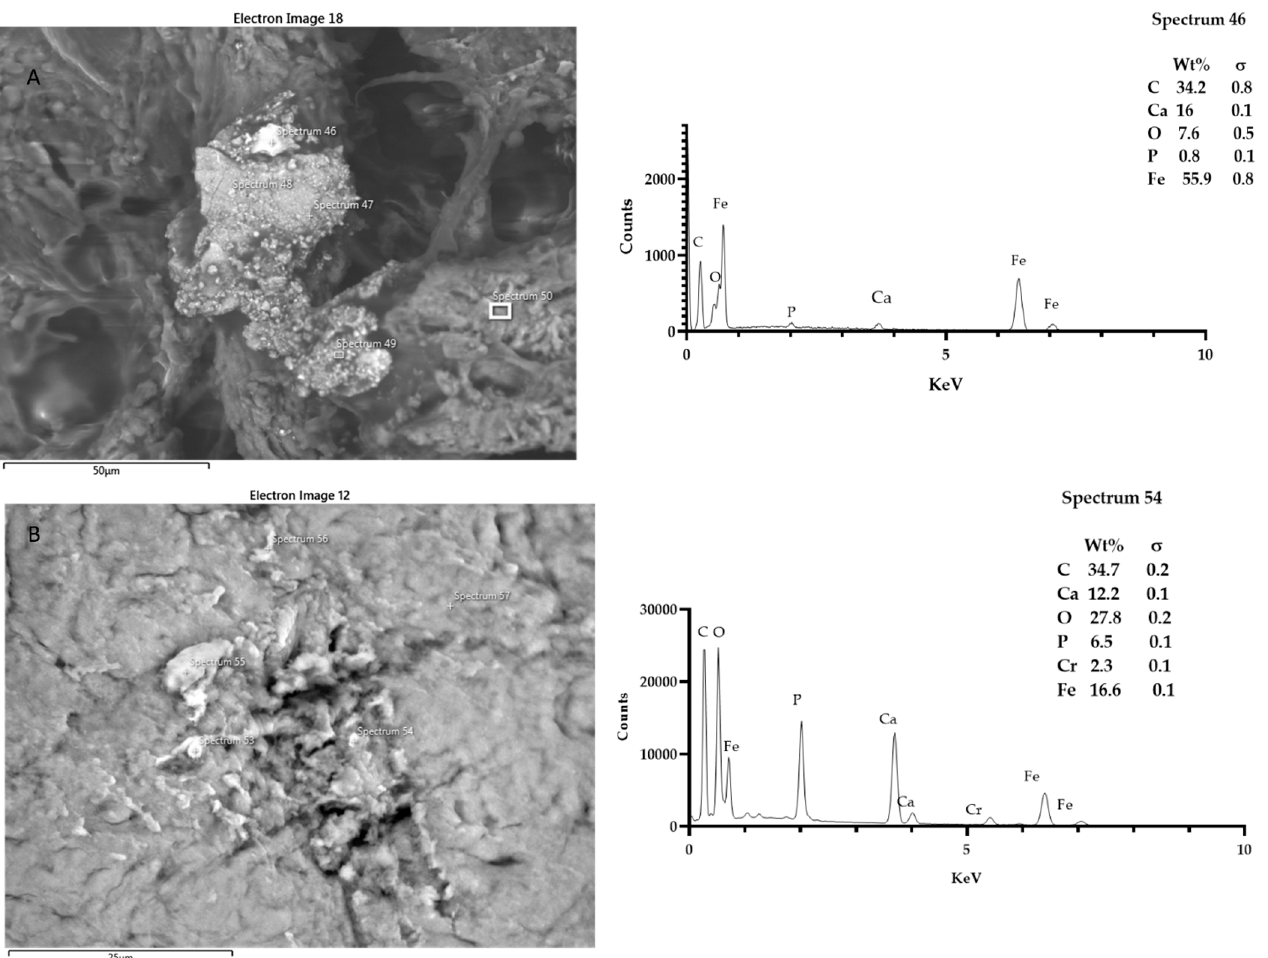
Figure 6. SEM-EDX analysis of samples T1 ( A ) and T2 ( B ). Looking at the morphology of the bone tissue of the samples T1 and T2, it was possible to notice some somewhat luminescent particles. However, the particles analyzed in T1 and T2 had the typical composition of bone tissue: calcium phosphate and carbon. Spectra outputs were realized using GrapPad Prism 9.3.1.